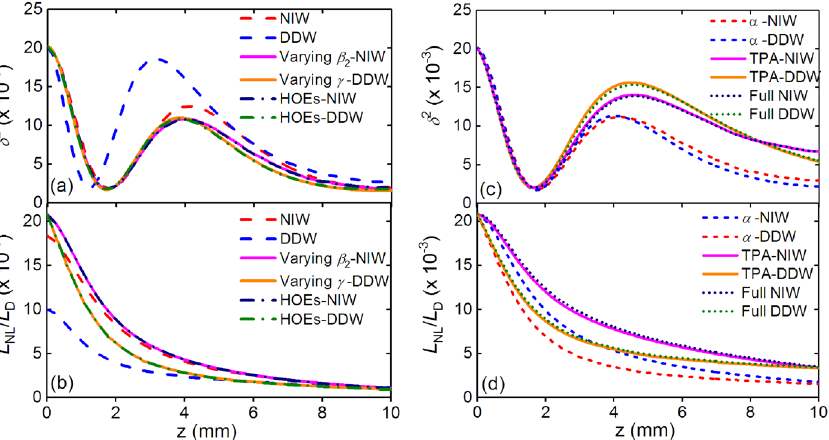
Figure 8. ( a ) The mismatch factor δ 2 and ( b ) ratio L NL / L D at 1550 nm for NIW (red dashed curves), DDW (blue dashed curves), varying β 2 -NIW (magenta solid curves), varying γ -DDW (orange solid curves), HOEs-NIW (navy dash-dotted curves) and HOEs-DDW (olive dash-dotted curves). ( c ) The mismatch factor δ 2 and ( d ) ratio L NL / L D at 1550 nm for α -NIW (blue dashed curves), α -DDW (red dashed curves), TPA-NIW (magenta solid curves), TPA-DDW (orange solid curves), Full NIW (navy dash-dotted curves), and Full DDW (olive dash- dotted